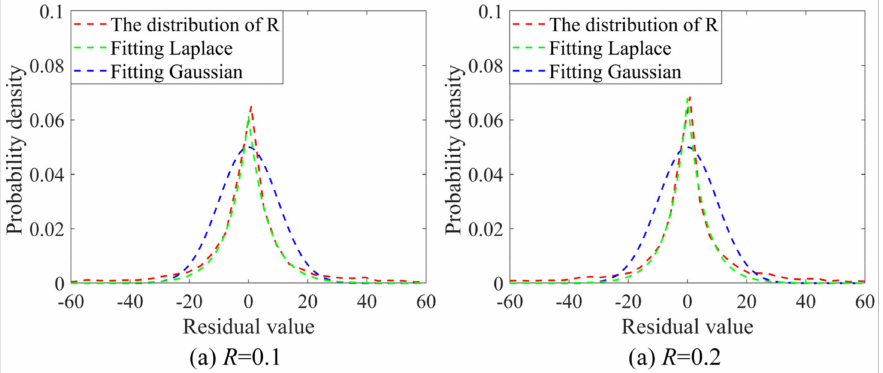
Figure 2. The group sparse residual distribution of the original and initial reconstructed images at different sensing rates: ( a ) R = 0.1, ( b ) R =